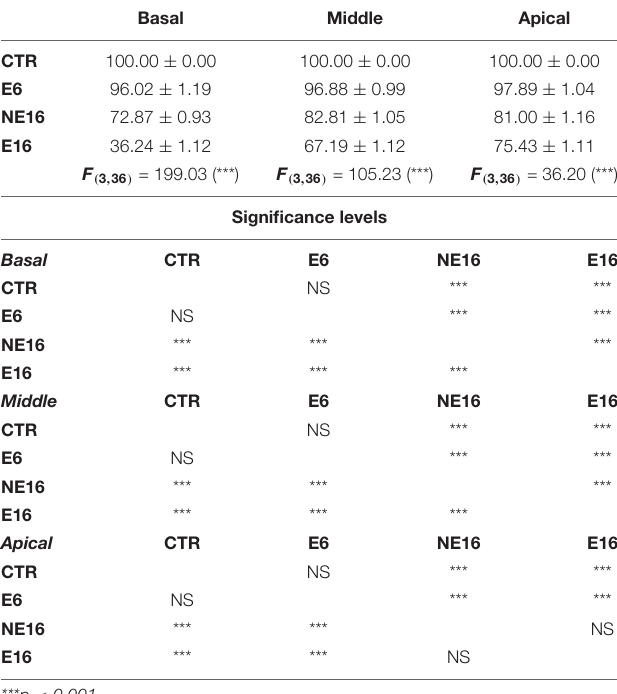
TABLE 5 | Mean, SE, and ANOVA analysis of the interaction between age, noise over exposure and spiral ganglion cells survival in the cochlea relative to the control condition.